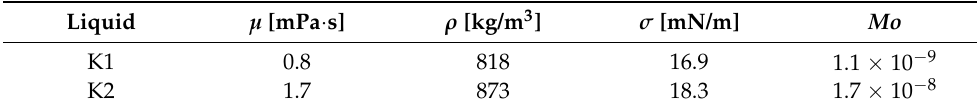
Figure 1. Schematic of experimental setup. Table 1. Characteristics of liquids in present experiment.